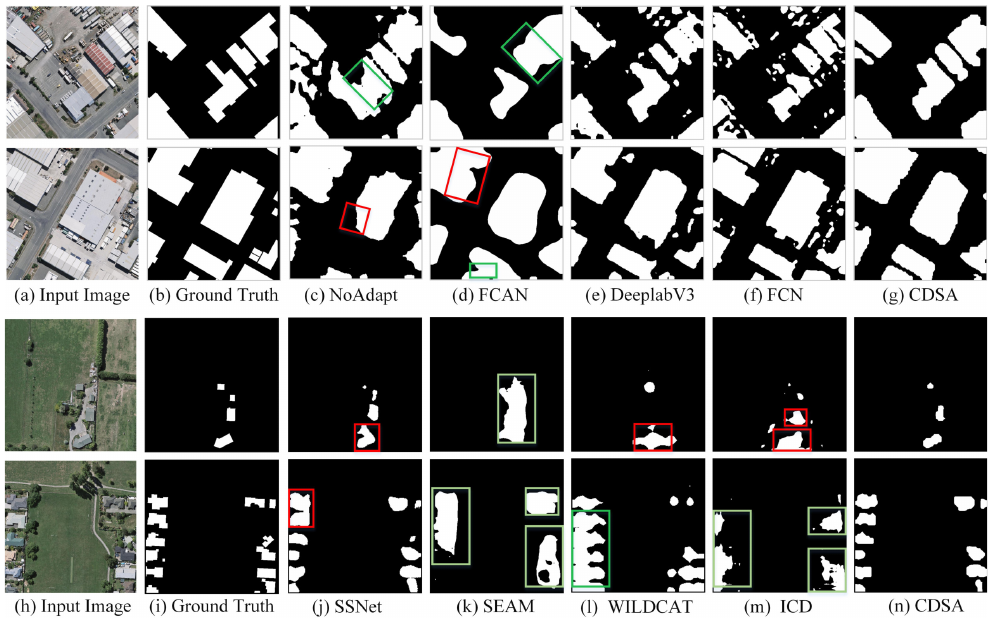
Figure 8. Comparison of qualitative analysis results on the WHU data set (Source domain: Inria data